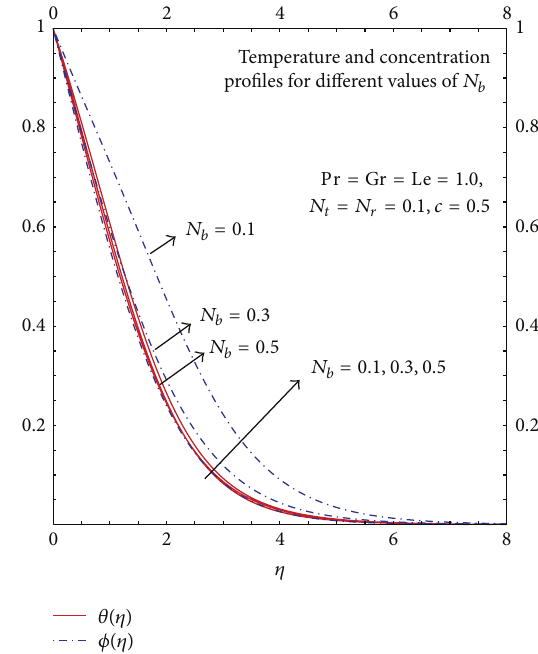
Figure 12: Graphs of 𝑓 𝜂 (𝜂) and 𝑆 𝜂 (𝜂) for different 𝑁 𝑏 . Figure 13: Graphs of